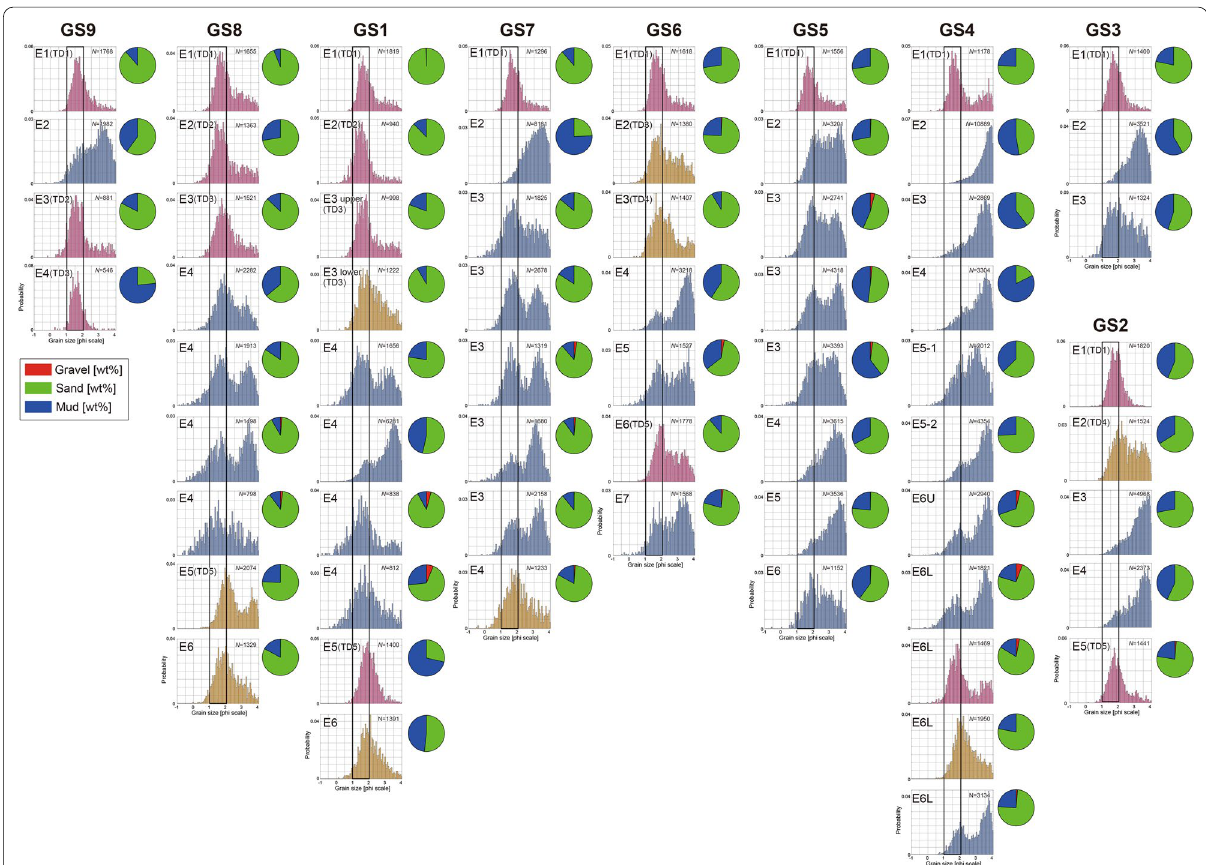
Fig. 7 Grain-size analysis of SKN-GS samples. Histograms show phi-scale grain-size distributions. Vertical axis indicates the probability of particles. Pie charts show gravel, sand, and mud contents. N means the number of particle samples measured. In the histogram, blue means that the size distribution is different from that of present-day beach sediments (presented in Fig. 9); pink means that it is similar to that of present-day beach sediments; and orange means that it is somewhat similar. Mean, median, mode, skewness, and kurtosis of each histogram are shown in Additional file 2: Table